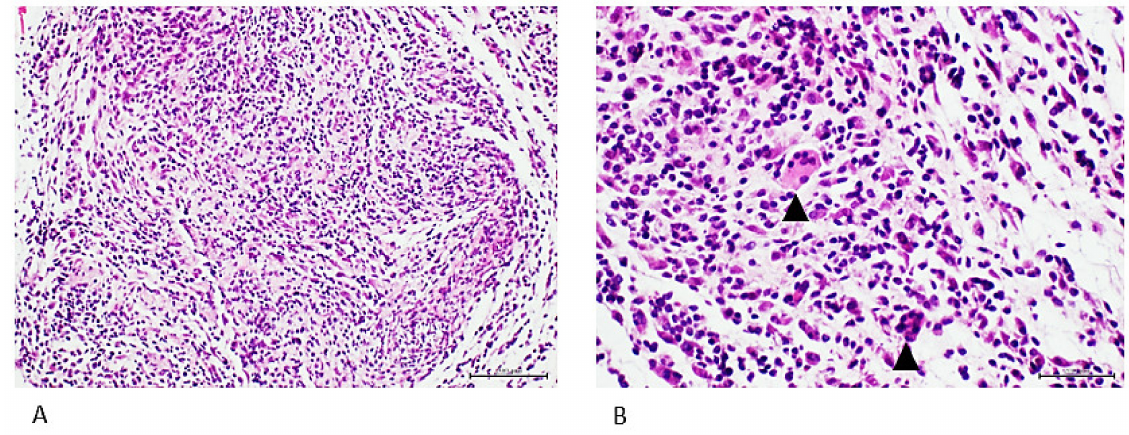
Figure 4. The mesenchymal cells tumor. This was a readily detected interscapular nodule during necropsy. ( A ) Panoramic image ( × 4) demonstrating intense cellularity and local disorganization. ( B ) Larger magnification ( × 40) reveals intense basophilic and pleomorphic nuclei, cells with embry- onic aspect and giant multinucleated cells (arrowhead). H/E. Scale bar: 200 µ m.